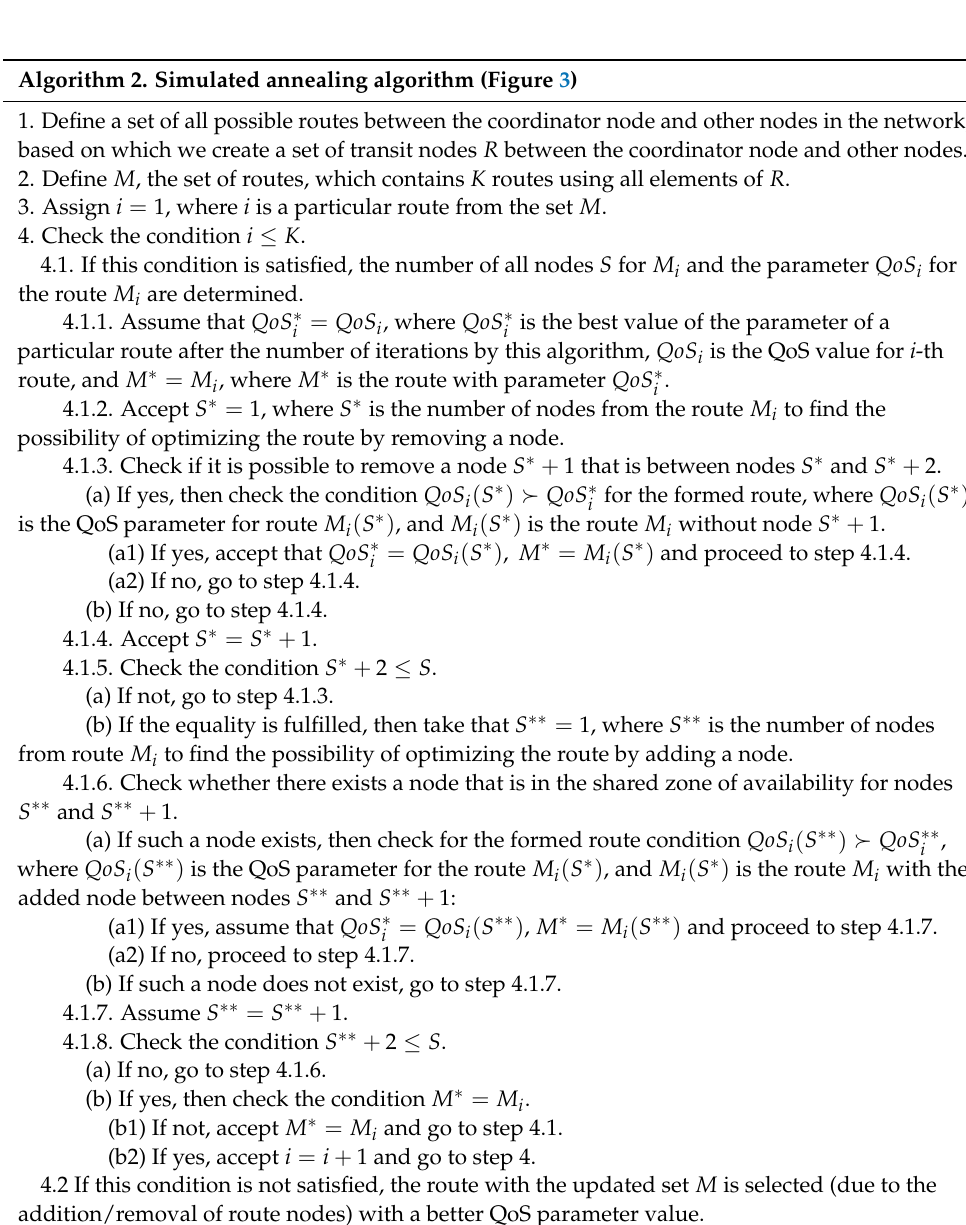
Algorithm 2. Simulated annealing algorithm (Figure